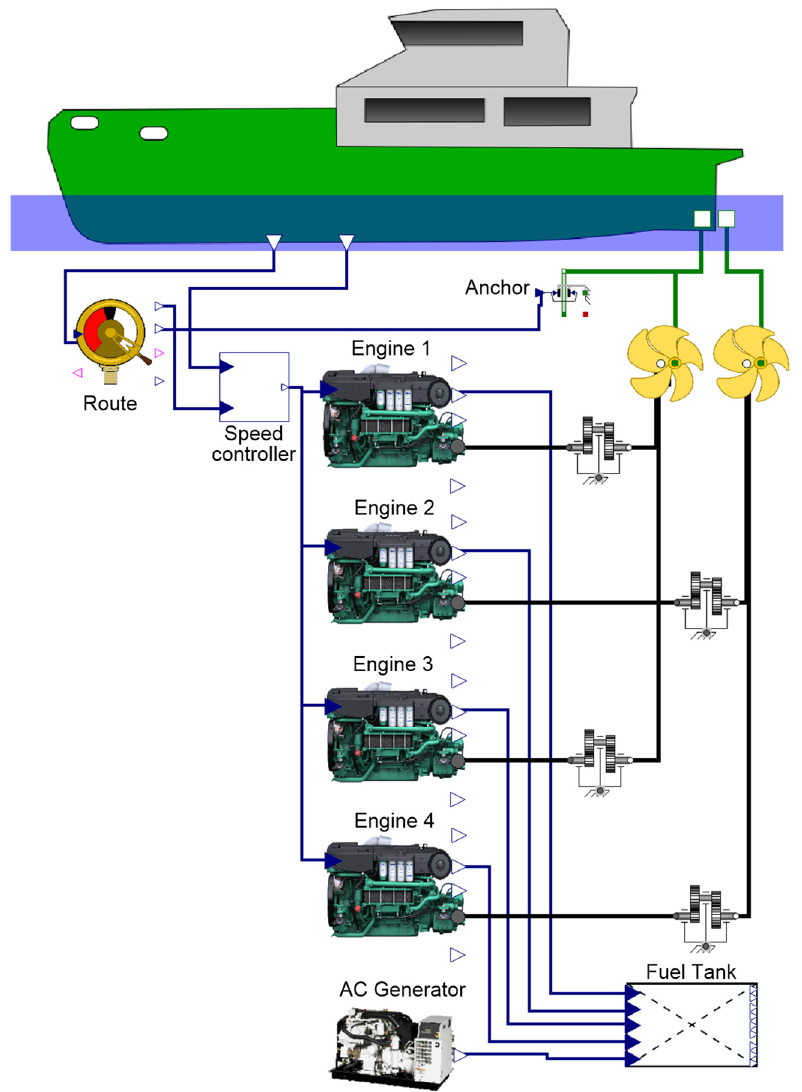
Figure 8. Model of a Diesel-Propeller Catamaran powertrain developed in Modelica.